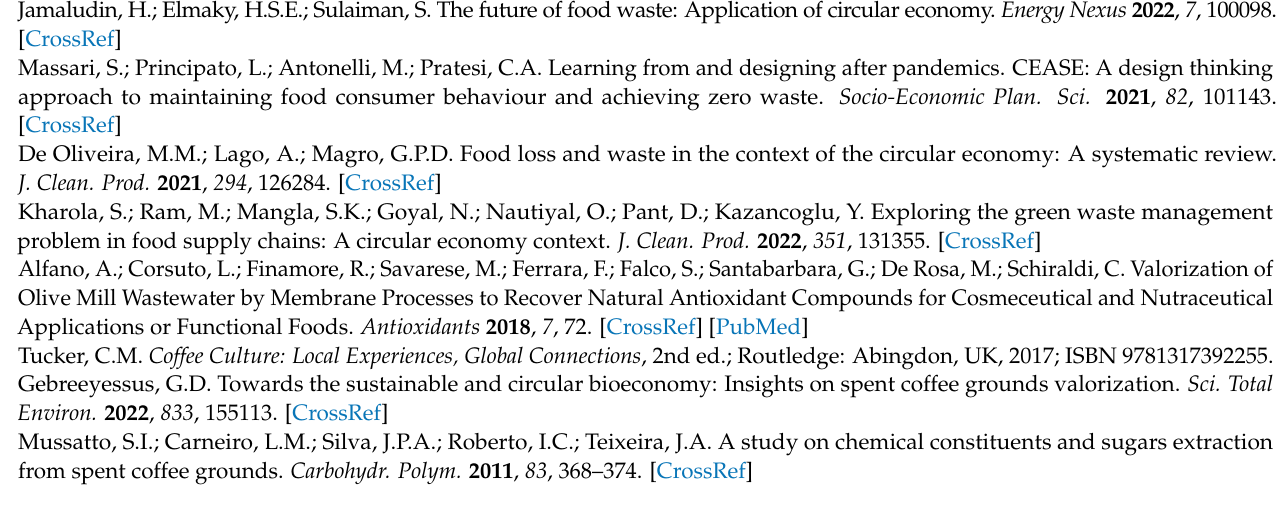
mg/g) (plot A) and desirability function (plot B) for the optimization of the extraction of spent coffee grounds performed with hydroethanolic solutions. The inset tables provide statistics related to the evaluation of the resulting model. Values with color and asterisk are statistically significant.; Figure S2: Plot of actual vs. predicted response (polyphenols, mg GAE/g) (plot A) and desirability function (plot B) for the optimization of the extraction of spent coffee grounds performed with hydroethanolic solutions. The inset tables provide statistics related to the evaluation of the resulting model. Values with color and asterisk are statistically significant.; Figure S3: Plot of actual vs. pre- dicted response (FRAP, µ moL AAE/g) (plot A) and desirability function (plot B) for the optimization of the extraction of spent coffee grounds performed with hydroethanolic solutions. The inset tables provide statistics related to the evaluation of the resulting model. Values with color and asterisk are statistically significant.; Figure S4: Plot of actual vs. predicted response (DPPH, µ moL DPPH/g) (plot A) and desirability function (plot B) for the optimization of the extraction of spent coffee grounds performed with hydroethanolic solutions. The inset tables provide statistics related to the evaluation of the resulting model. Values with color and asterisk are statistically significant.; Figure S5: Bivariate response fitting plot (caffeine vs. polyphenols) for the optimization of spent coffee grounds extraction performed with hydroethanolic solutions. The inset tables provide statistics related to the evaluation of the resulting model. Values with color and asterisk are statistically significant.; Figure S6: Bivariate response fitting plot (FRAP vs. polyphenols) for the optimization of spent coffee grounds extraction performed with hydroethanolic solutions. The inset tables provide statistics related to the evaluation of the resulting model. Values with color and asterisk are statistically significant.; Figure S7: Bivariate response fitting plot (DPPH vs. polyphenols) for the optimization of spent coffee grounds extraction performed with hydroethanolic solutions. The inset tables provide statistics related to the evaluation of the resulting model. Values with color and asterisk are statistically